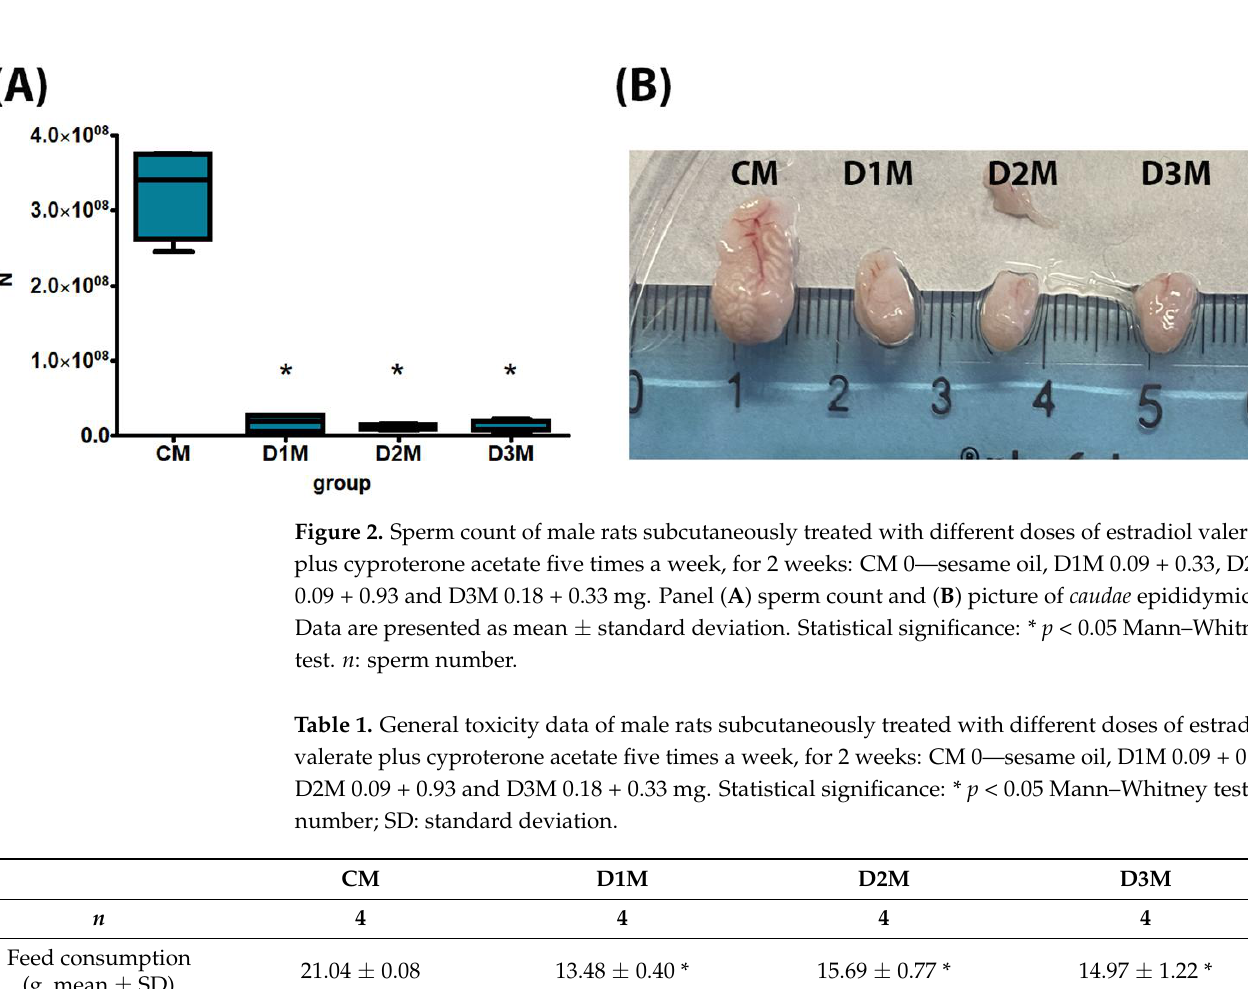
Figure 1. Body weight (bw) of male rats subcutaneously treated with different doses of estradiol valerate plus cyproterone acetate five times a week, for 2 weeks: CM: 0 — sesame oil, D1M 0.09 + 0.33, D2M 0.09 + 0.93 and D3M 0.18 + 0.33 mg. Panel ( A ) bw gain and ( B ) bw at treatment days 5, 8, 12 and 13. Data are presented as mean ± standard deviation. Statistical significance: * p < 0.05 Mann – Whitney test.